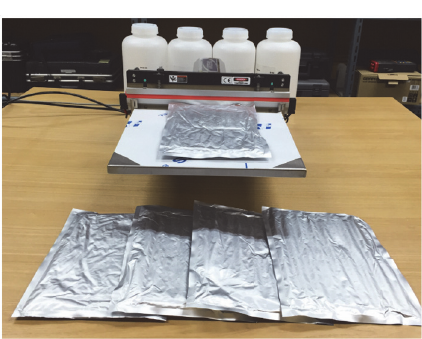
Figure 4: PTSCs embedded with PCM 35, 37, 41, and 44 ∘ C.